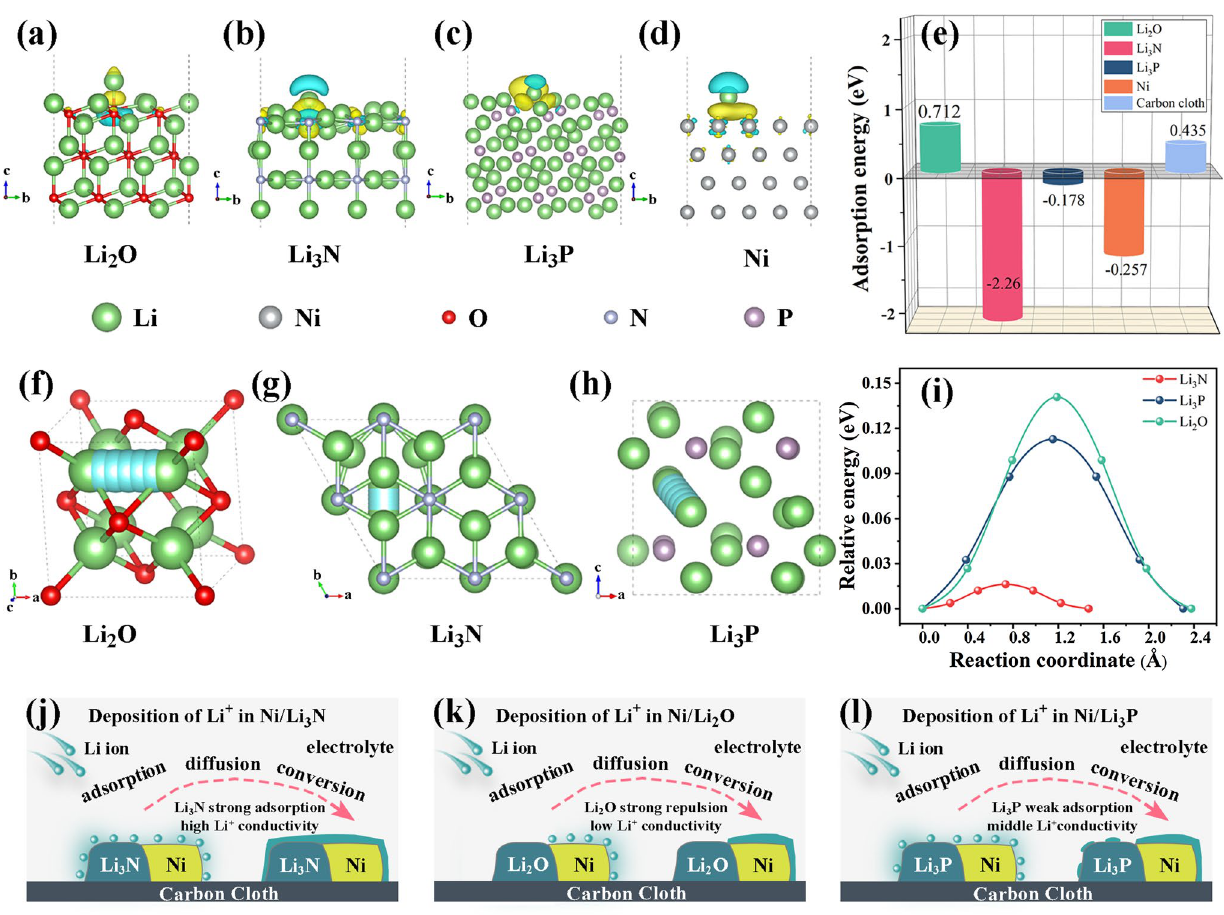
Fig. 3 Adsorption model structure and differential charge density of Li atom on a Li 2 O, b Li 3 N, c Li 3 P, and d Ni. The yellow and cyan regions represent electron accumulation and depletion, respectively. e The corresponding adsorption energy of a Li atom on crystal surfaces. The opti- mized diffusion path through f Li 2 O, g Li 3 N, and h Li 3 P. i The comparison plot of the corresponding energy barrier. Illustrations of the working mechanism of j Ni/Li 3 N, k Ni/Li 2 O, and l Ni/Li 3 P for lithium ion